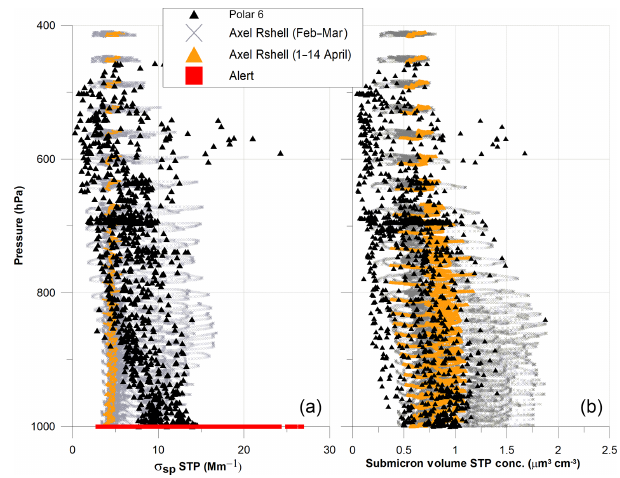
Figure 13. (a) Vertical profile plot of σ sp from the model for the Axel grid (black crosses for February–14 April, inclusive; orange triangles for 1–14 April only) and σ sp from the Polar 6 observations plotted with pressure. Also shown are the Alert observatory σ sp for 1–14 April. (b) As in (a) but for submicron volume concentrations from the model simulations and Polar 6 observations. Volume con- centrations from the Alert observatory are not